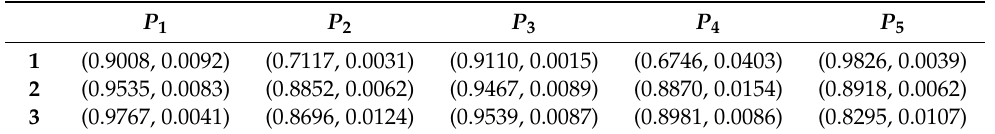
Table 5. The final reputation rating matrix M .